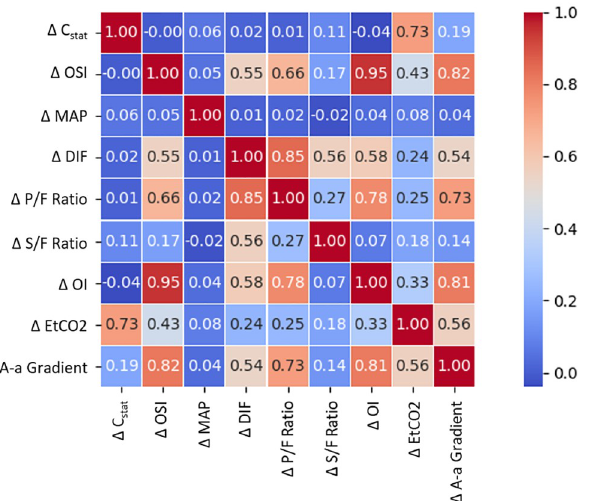
Fig 3. The selected parameters for investigation are compared with each other to determine their dependence. The PPMCC method is used to calculate a value between -1 (inversely correlated) and 1 (correlated). Those with low correction (close to 0) are more independent of each other and are therefore the best candidates for informed decision-